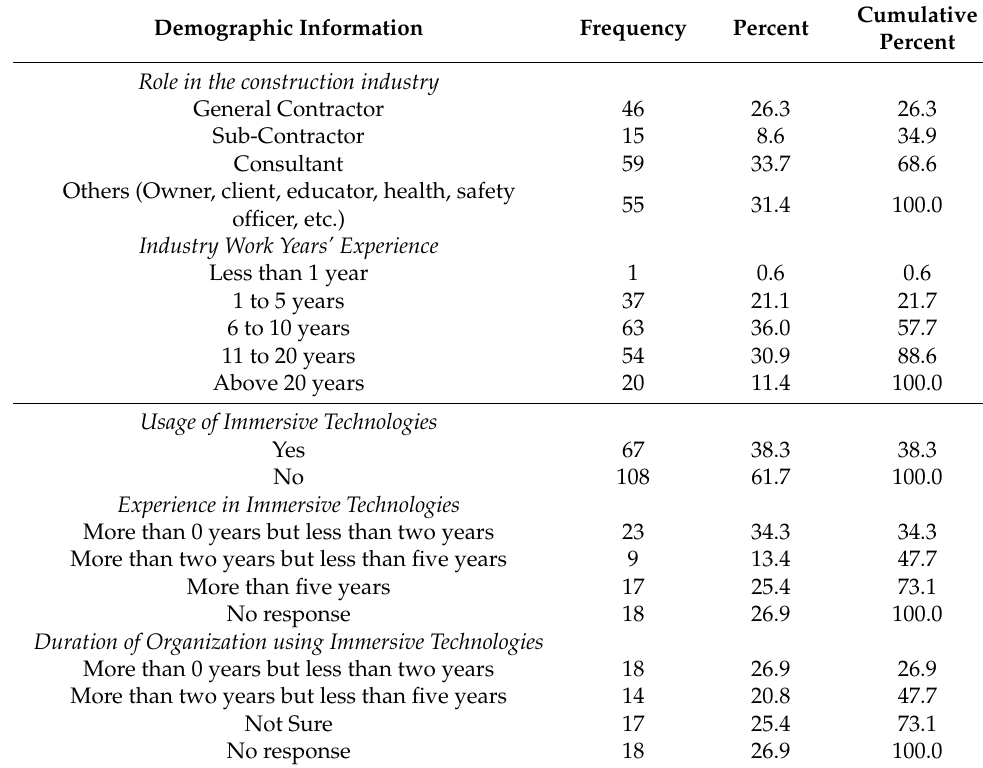
Table 3. Personal characteristics of the survey